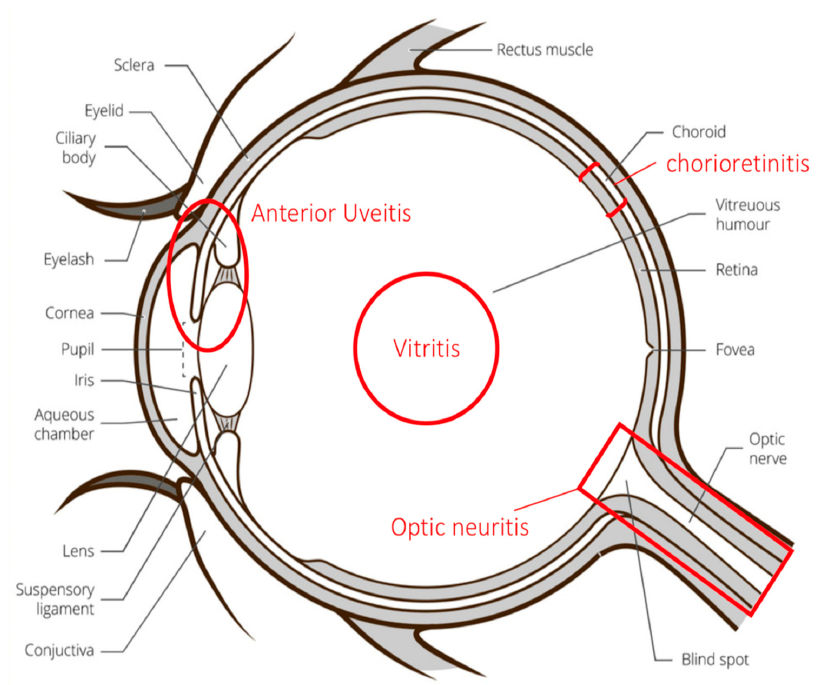
Figure 1. The different ocular structures involved during West Nile virus infection. Anterior uveitis may involve the anterior components of the uvea, which includes the iris and ciliary body.